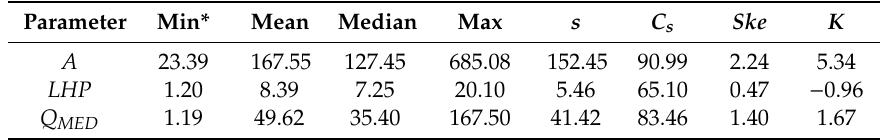
Table 2. Basic statistical parameters of analyzed variables.